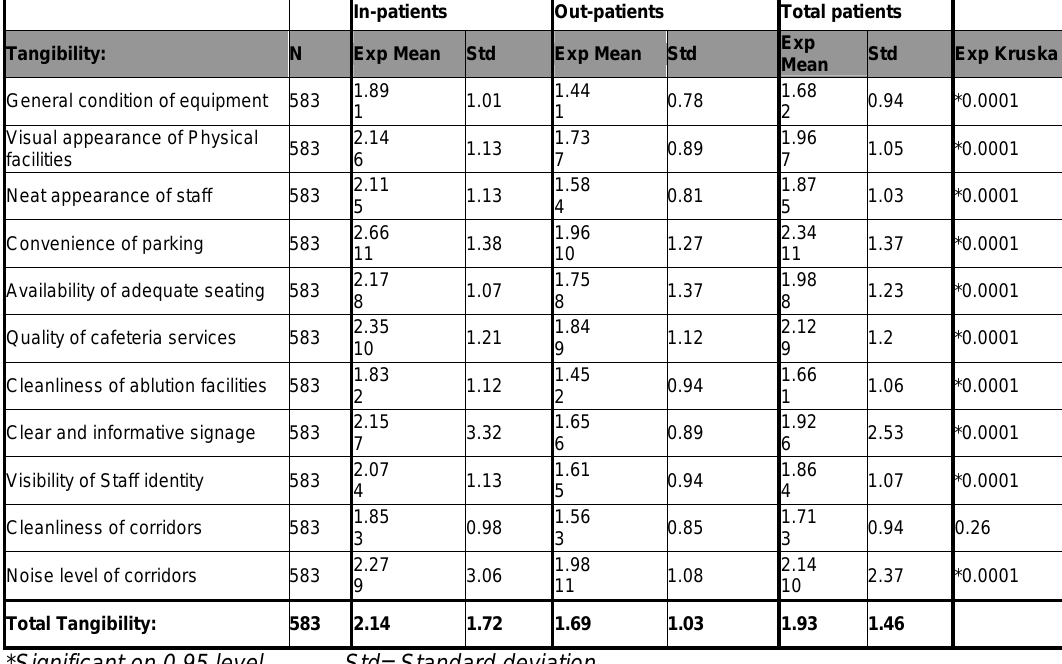
Table 1: Test for differences with regards to expectations on tangibility constructs In-patients Out-patients Total